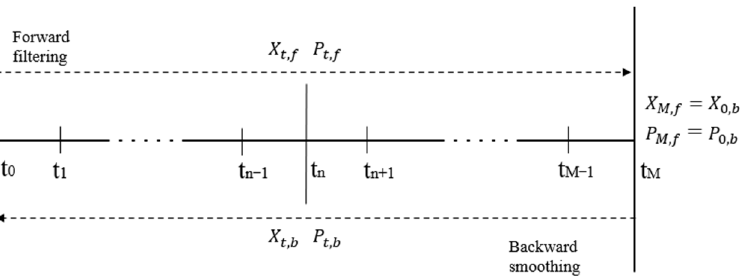
Figure 1. RTS smoothing algorithm flow.